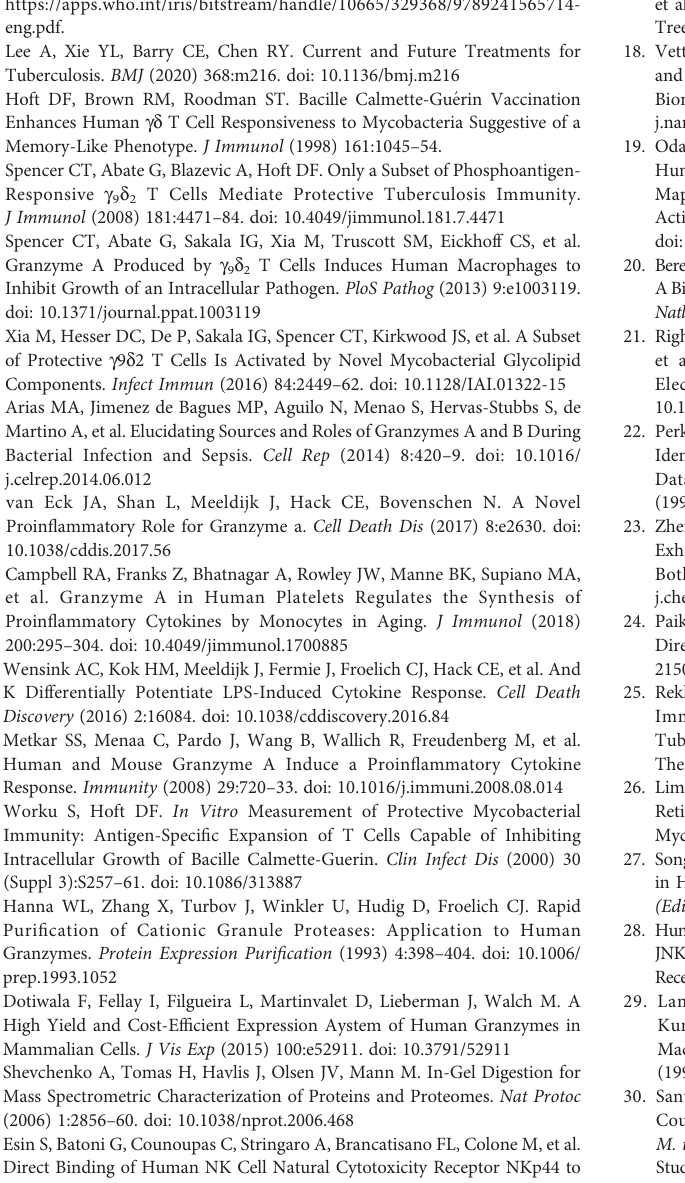
Supplementary Figure 3 | Work fl ow diagram of global proteomic experiment and rationaleforproteinofinterest.PBMCweretreatedornotwithGzmA,andinfectedor not with BCG for 36 h. Cells were then washed with PBS, lysed with protease and phosphatase inhibitors, and downstream 2D-DIGE work fl ow. Example of matched spot #431. Melanie software analysis discovered this protein spot that was differentially abundant only in group 4 (BCG-infected, GzmA-treated monocytes) in two volunteers. Each labeled spot was normalized with CyDye2 labeling. Supplementary Figure 4 | STRING-DB enrichment pathways highlights ER stress response pathway involved in GzmA-mediated mycobacterial control.